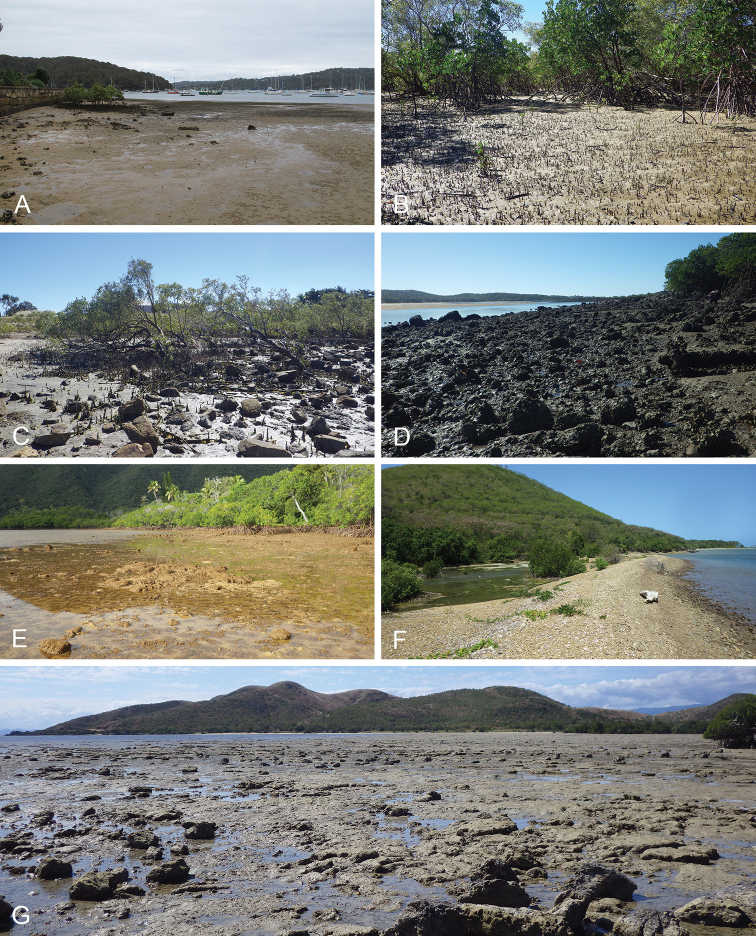
Habitats, Peronia
sydneyensisA Australia, New South Wales, sand, next to a small patch of mangrove, and rocks on sandy beach (st 39, type locality) B Australia, Queensland, Rhizophora, across Doughty’s creek, coarse sandy area (st 118) C Australia, Queensland, Sonneratia, rocks on beach near a Rhizophora and Avicennia mangrove (st 119) D Australia, Queensland, by boat ramp, mangrove margin with large rocks by creek (st 121) E New Caledonia, intertidal sandy coral rubble flat in front of a mangrove (st KM 524) F New Caledonia, landlocked coastal mangrove, small pocket of Rhizophora and Avicennia with a large brackish pool set behind a stony beach (st KM 539) G New Caledonia, muddy intertidal rocky flat in front of mangroves (st KM 538).